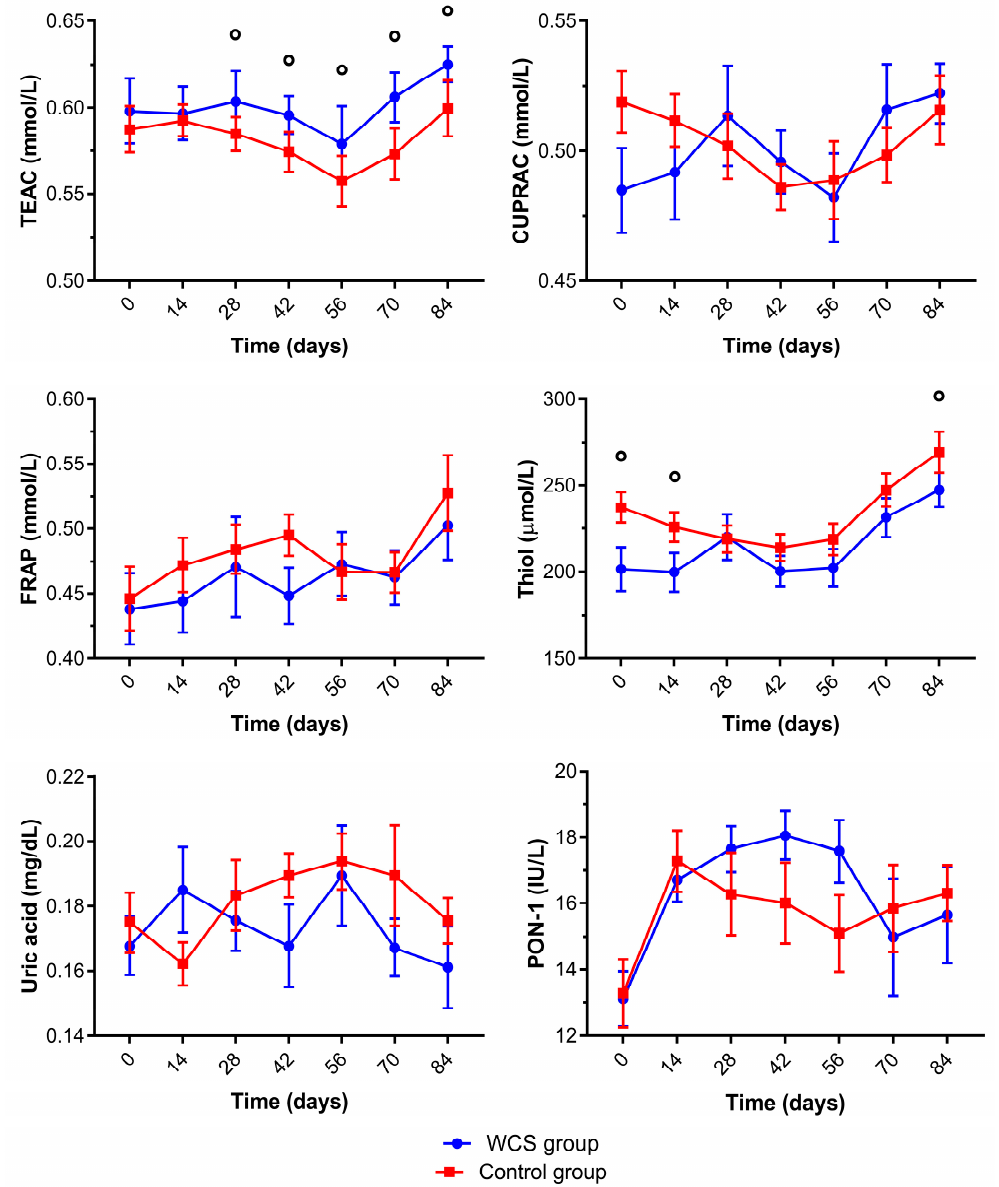
Figure 4. Mean (±standard error of the mean) of trolox equivalent antioxidant capacity (TEAC), cupric reducing antioxidant capacity (CUPRAC), ferric reducing ability of plasma (FRAP), thiol, uric acid, and paraoxonase-1 (PON-1) concentrations of crossbred lambs naturally infected with gastrointestinal nematodes and Eimeria spp. receiving two different diets (whole cottonseed and control) at seven different samplings (0–84 days). There was an interval of 14 days between each sample collection. ° Significantly difference between groups.